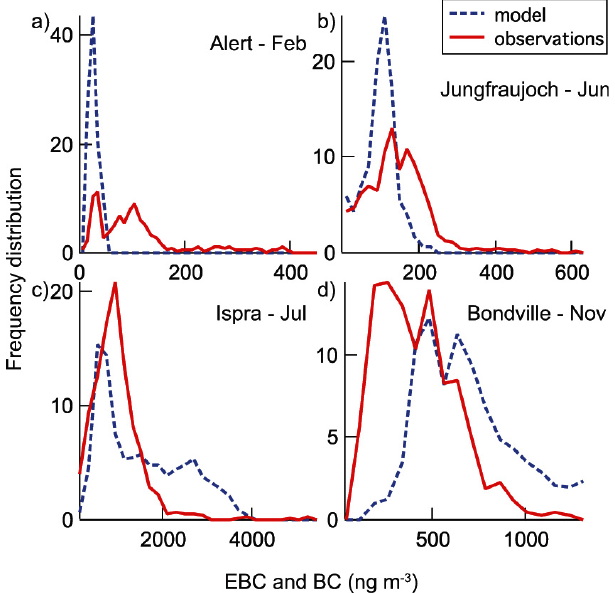
Fig. 9. PD curves of model (blue) and observations (red) at Alert in February (a) , at Jungfraujoch in June (b) , at Ispra in July (c) , and at Bondville in November (d)